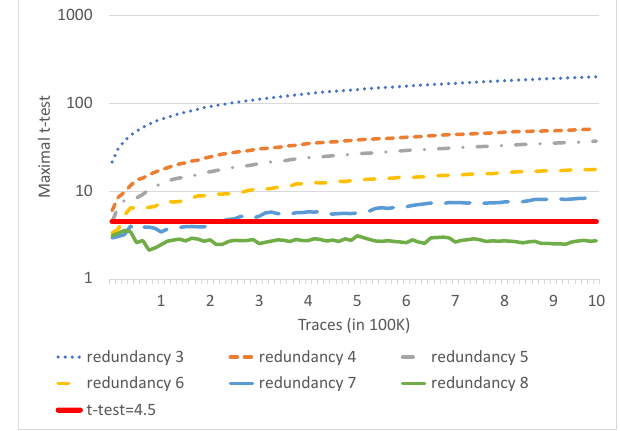
Figure 3: Maximal t-test as a function of the number of traces for different redundancy values (1 Sbox with